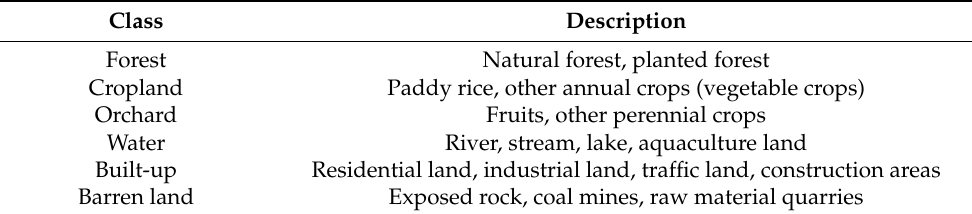
Table 2. Descriptions of the LULC classes used in this